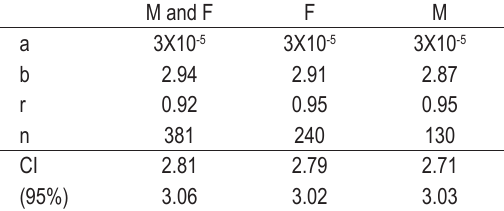
Table 2. Length-weight relationship of A. fasciatus.